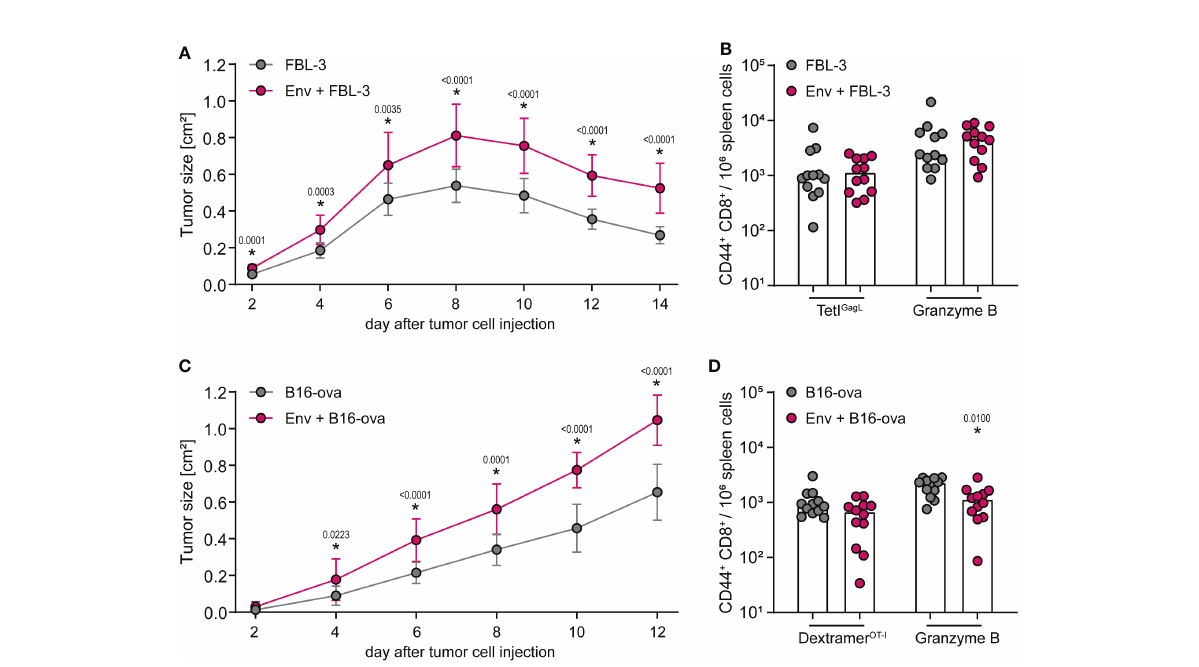
FIGURE 4 Control of tumor cell growth is impaired after F-MuLV Env immunization. (A, B) CB6F1 mice were inoculated with 5 × 10 6 FBL-3 cells by subcutaneous injection with or without an immunization with 25 µg of F-MuLV Env (SU+TM) encoding plasmid pCG.env 3 days before. Tumor size was measured every other day (A) , and 14 days after tumor cell injection, mice were sacri fi ced and the frequency of GagL 85-93 -speci fi c CD8 + T cells and of granzyme B + CD8 + T cells in spleen cells was determined by fl ow cytometry (B) . (C, D) CB6F1 mice were inoculated with 5 × 10 6 B16-ova cells by subcutaneous injection with or without an immunization with 25 µg of F-MuLV Env encoding plasmid pCG.env 3 days before. Tumor size was measured every other day (C) , and 12 days after tumor cell injection, mice were sacri fi ced and the frequency of Ova 257-264 -speci fi c CD8 + T cells and of granzyme B + CD8 + T cells in spleen cells was determined by fl ow cytometry (D) . Data from 12 mice per group were acquired in three independent experiments. (A, C) The mean tumor size with standard deviation. (B, D) Each dot indicates an individual mouse, and bars indicate median values. Statistically signi fi cant differences compared with the unvaccinated group at the same time point (A, C) or compared with the respective cells of unvaccinated mice (B, D) are indicated by * ( p < 0.05, Mann – Whitney rank sum